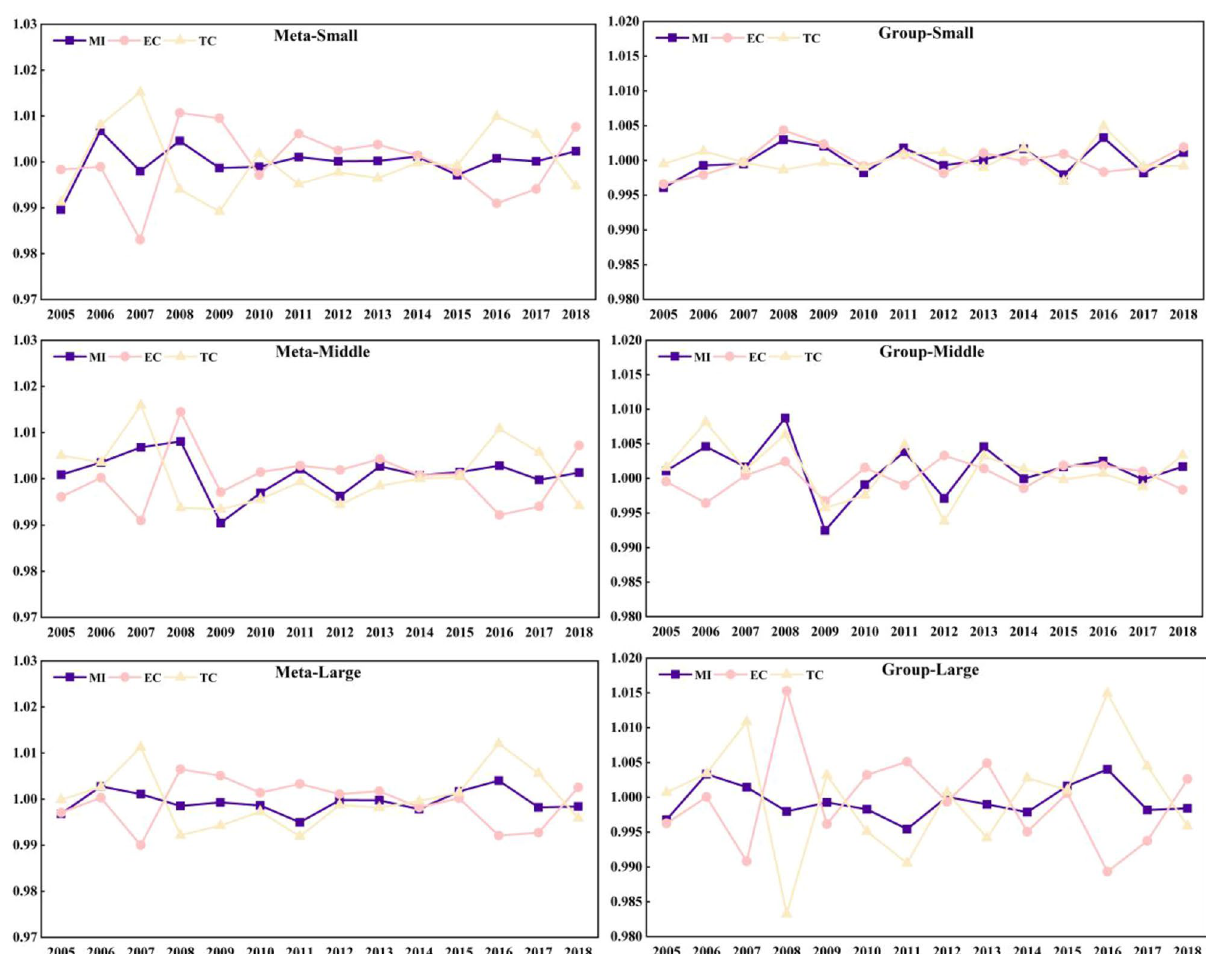
Figure 3. Three-sized LHG and its decomposition index from 2004 to